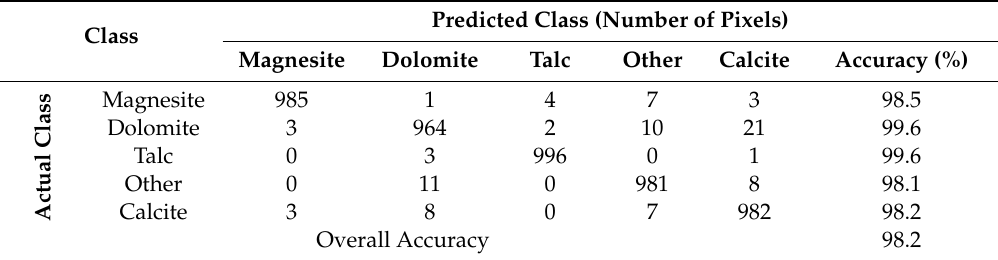
Table 4. A confusion matrix for the random forest model used for band